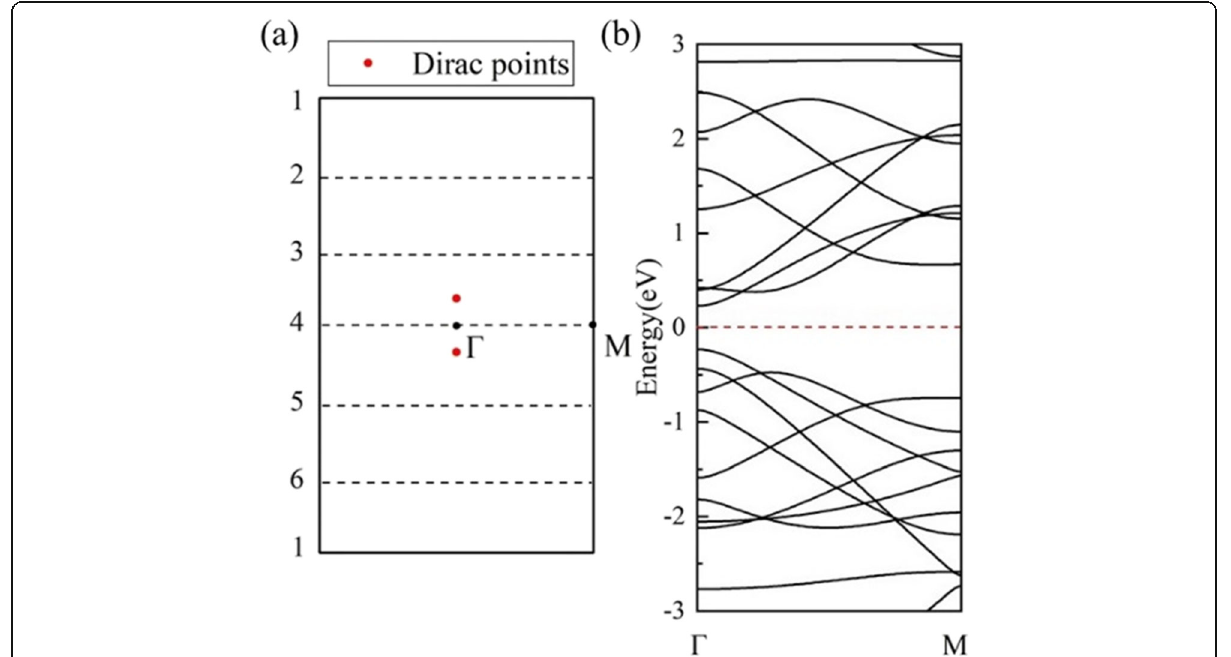
Fig. 7 ( a ) The first BZ of the HOT graphene with allowed k lines (dash lines) for the (1,0)6 nanotube; ( b ) band structures of the (1,0)6